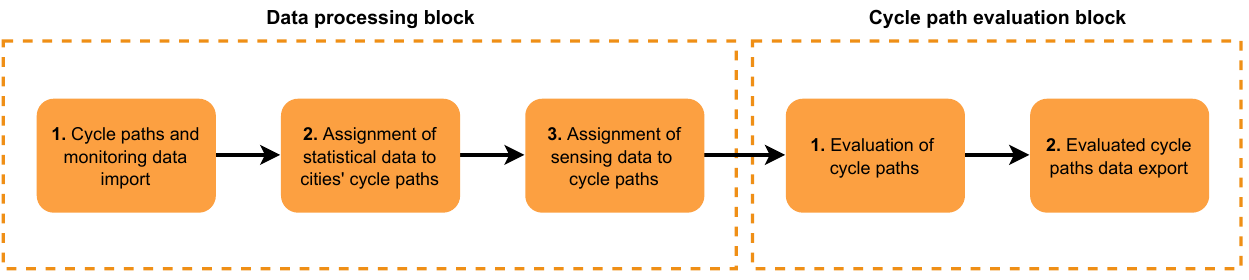
Figure 5. The conceptual diagram of the iBikeSafe evaluation